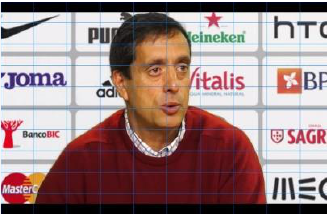
Figure 4. Stimulus plan with up to 12 logos.